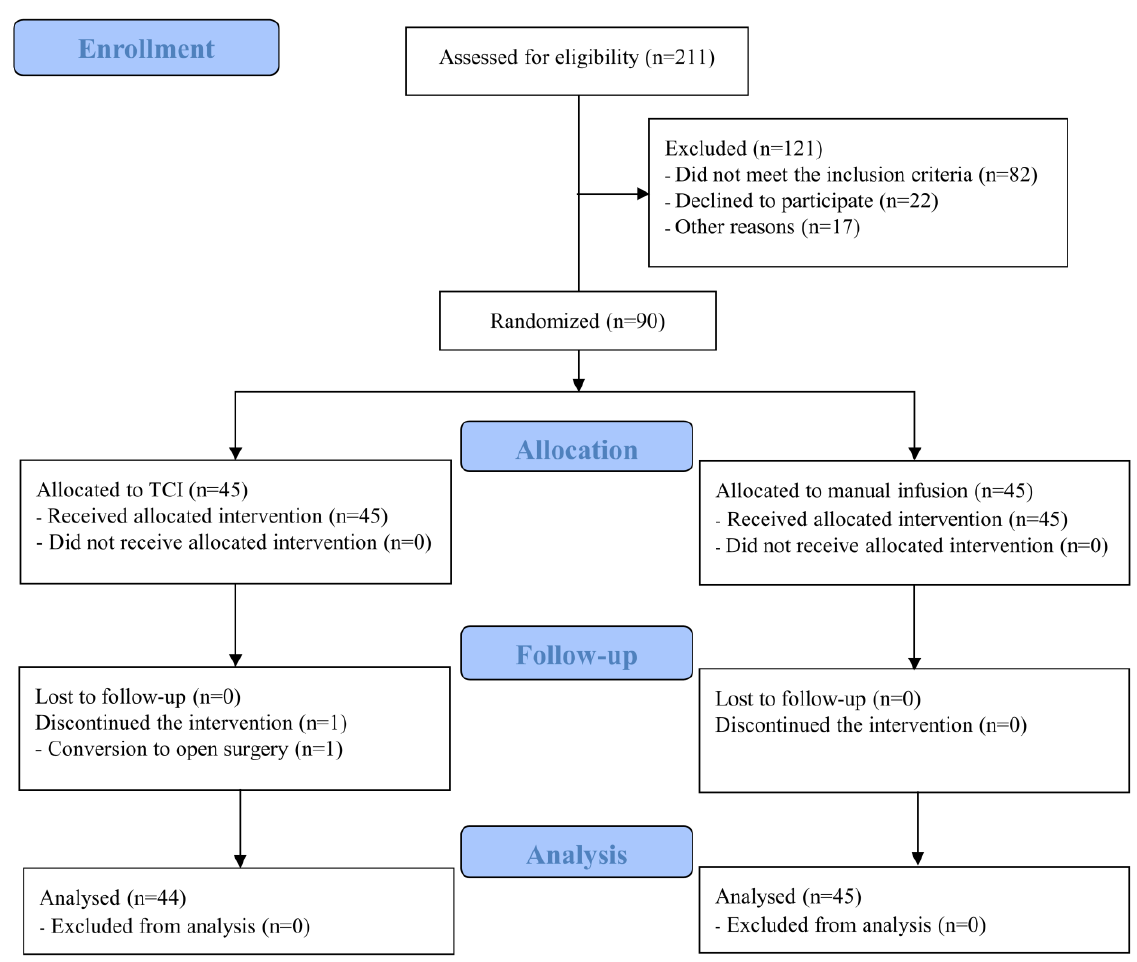
Figure 1. CONSORT diagram of the patient enrollment. TCI, target-controlled infusion; CONSORT, Consolidated Standards of Reporting Trials. Table 2. Postoperative secondary outcomes.